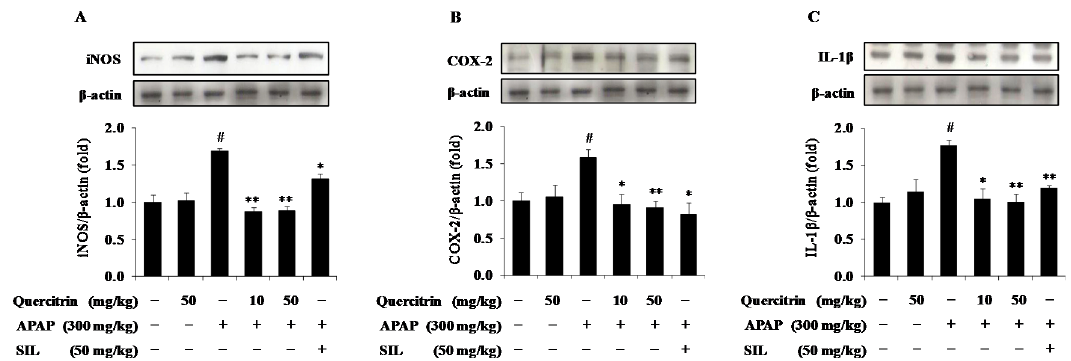
Figure 7. Effects of quercitrin on inflammatory response in APAP intoxicated mice. The hepatic inducible nitric oxide (iNOS) ( A ); cyclooxygenase 2 (COX-2) ( B ) and interleukin 1 β (IL-1 β ) ( C ) levels were evaluated by Western blot analysis. Protein expression levels were normalized with β -actin. All data represent means ± SD of five mice in each group. Significant differences were ( # ) p < 0.05 as compared with the control; (**) p < 0.01 or (*) p < 0.05 as compared with APAP group.